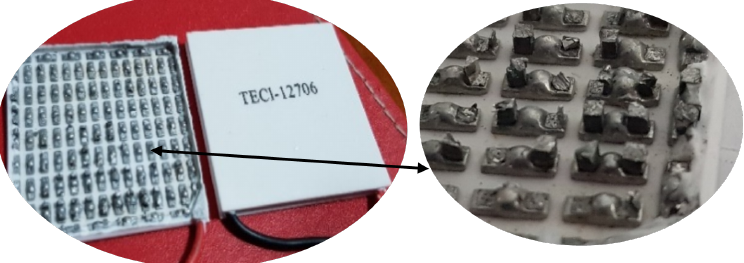
Figure 3. The Peltier (cooling module) arrangement.